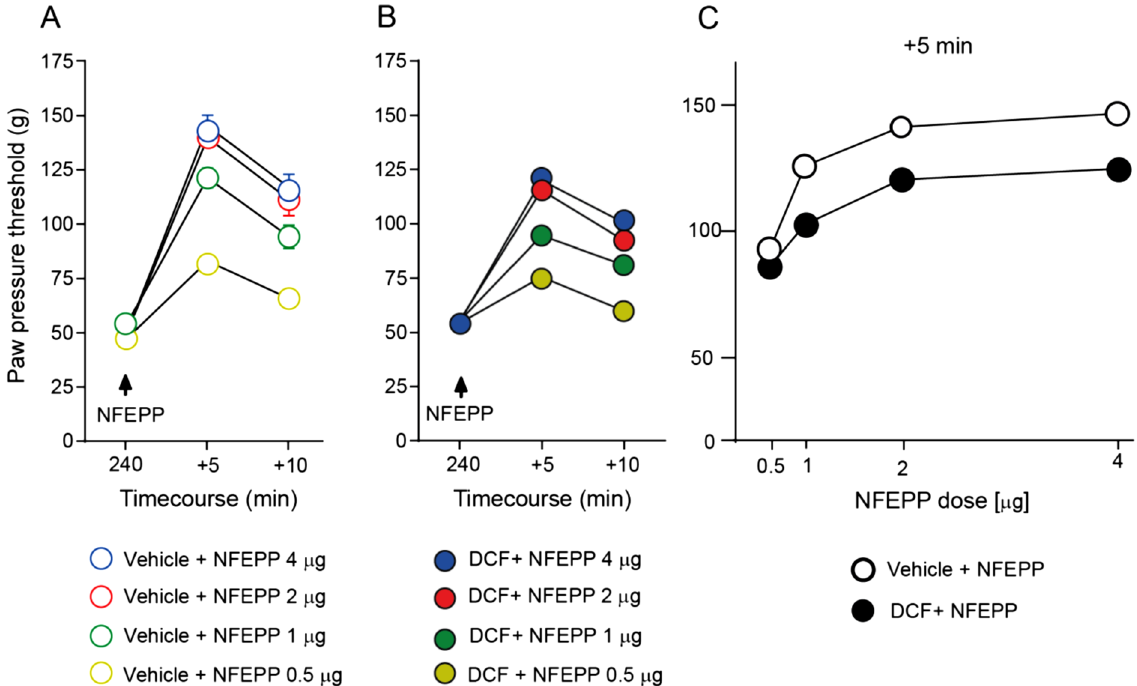
Figure 3. Antinociceptive efficacy of intraplantar (i.pl.) NFEPP after subcutaneous (s.c.) diclofenac. Dose- and time-dependent paw pressure threshold (PPT) elevations in inflamed paws after NFEPP (0.5–4 µg) injected i.pl. into inflamed paws, assessed after s.c. treatment with vehicle ( A ) or diclofenac (DCF; 20 mg/kg) ( B ) at 4 days after i.pl. complete Freund’s adjuvant inoculation. All PPT elevations were statistically significant at + 5 min ( P < 0.05 vs. 240 min, one-way RM ANOVA and Bonferroni test; not indicated for graph clarity). ( C ) DCF (20 mg/kg; s.c. daily for 4 days)-induced attenuation of PPT elevation produced by increasing doses of NFEPP (i.pl.) in inflamed paws at 5 min after NFEPP injection. P < 0.01 versus vehicle, area under the curve, two-tailed unpaired t-test. Data show means ± SEM (n = 8 rats per